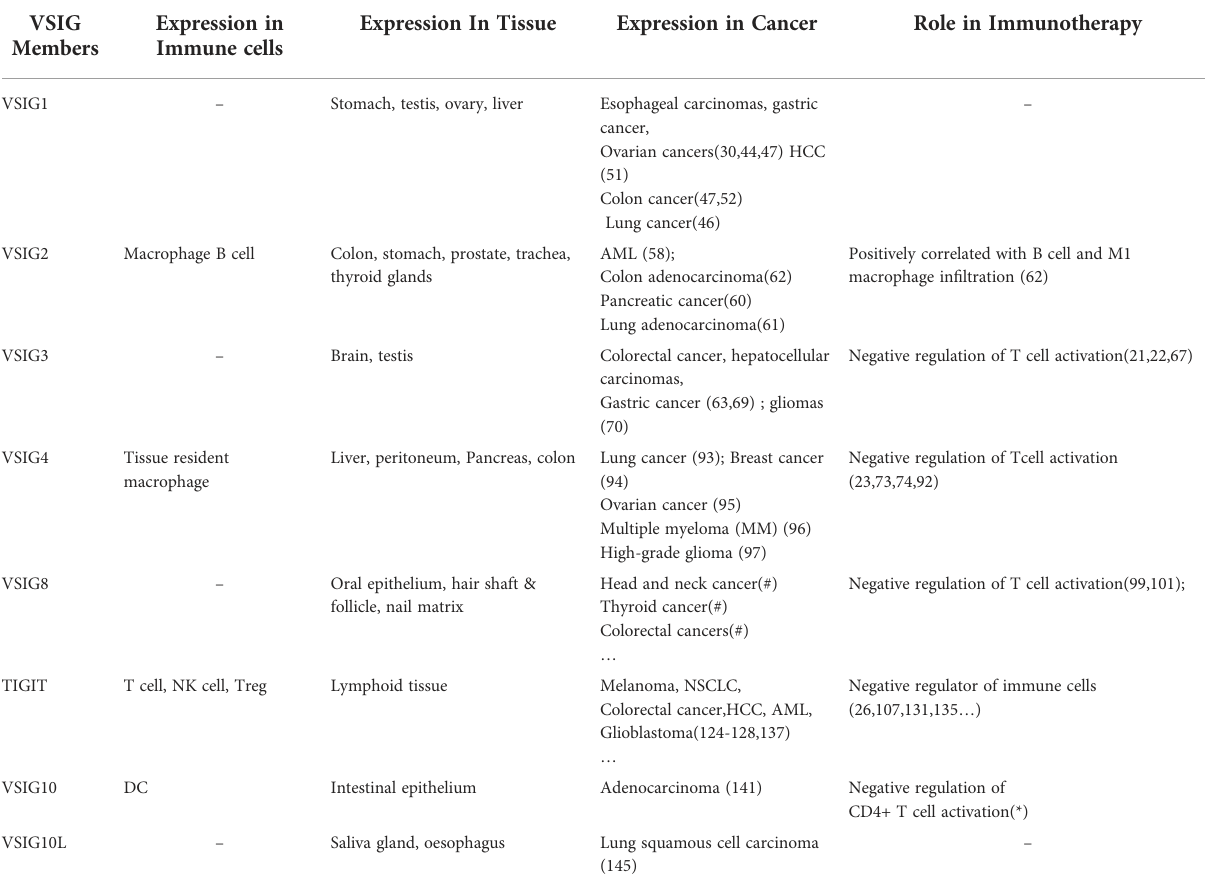
TABLE 2 Diverse expression and function of VSIG family